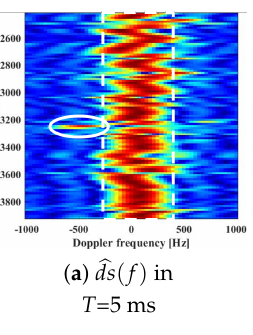
ds ( f ) and dv ( f ) in two different T (cid:98)